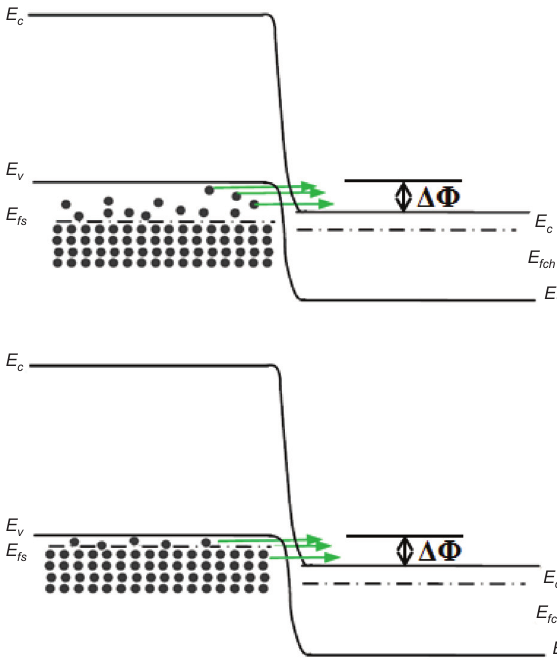
Figure 11 (A) Schematic band diagram of inefficient turn-ON of an n-type TFET device if the source region is highly